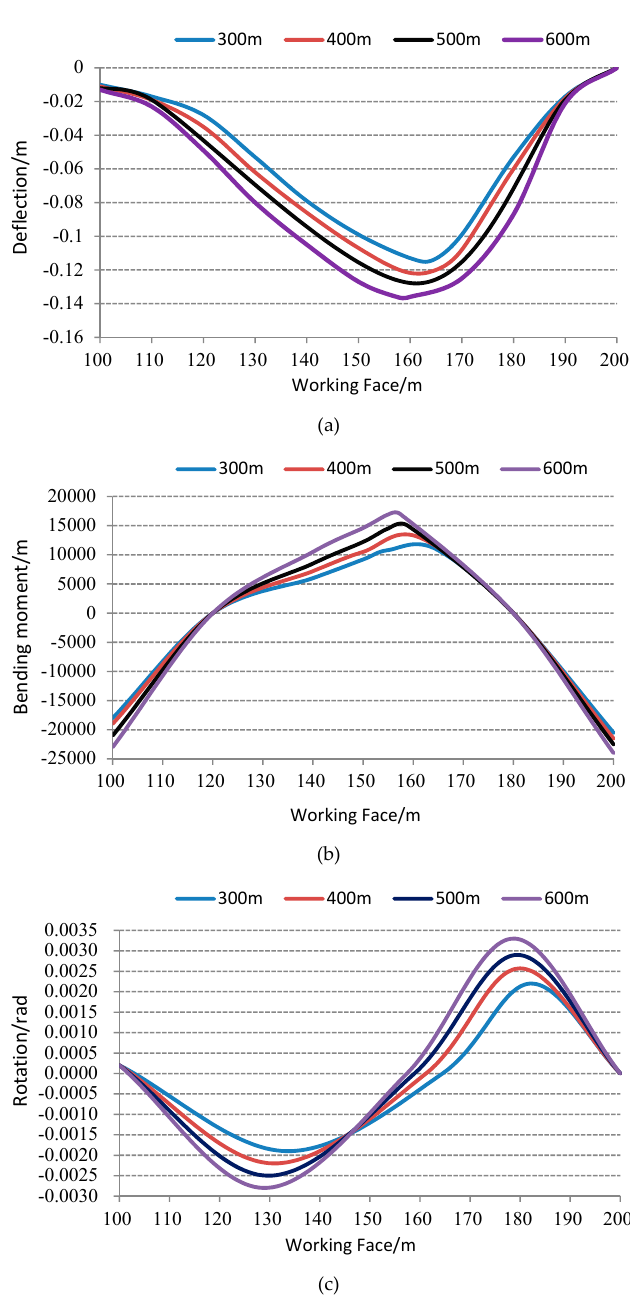
Figure 5. Roof deformation and internal force under different mining depths: ( a ) Deflection; ( b ) bending moment; and ( c ) rotation.